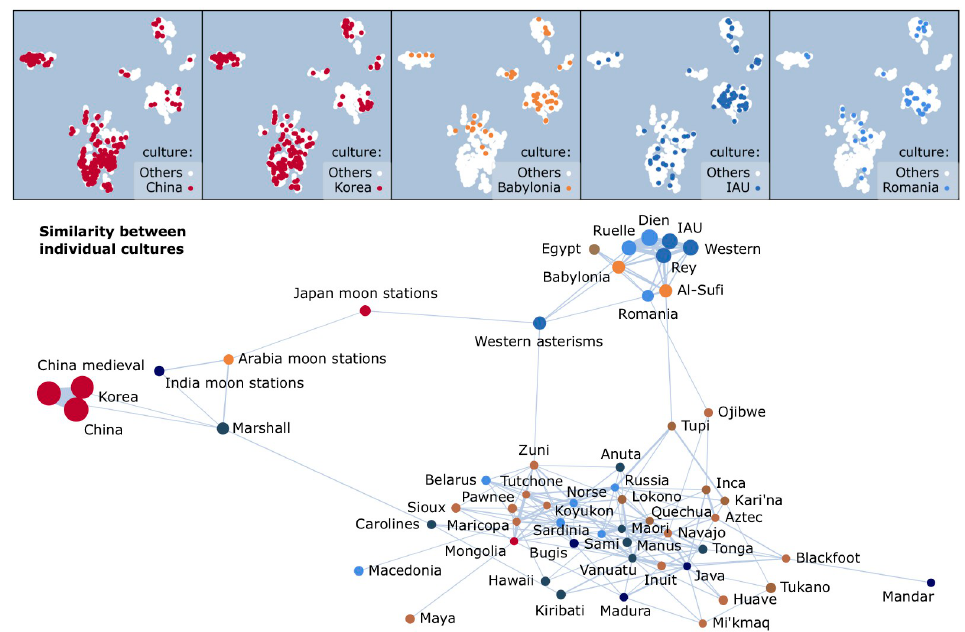
Fig 6. Visual signatures by culture (question I.1). (top) Constellations from example cultures are shown in the foreground, over the background of all other constellations. (bottom) The similarity graph for cultures. The node size is proportional to the number of constellations per culture, and the edge width to the similarity Δ